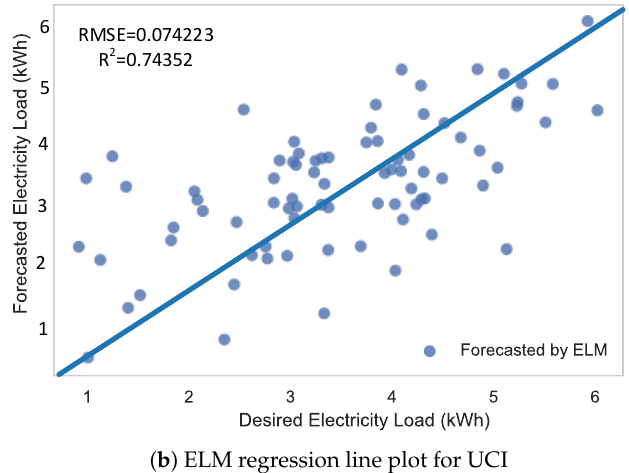
( b ) ELM regression line plot for UCI Figure 12. Regression line plots using ELM.